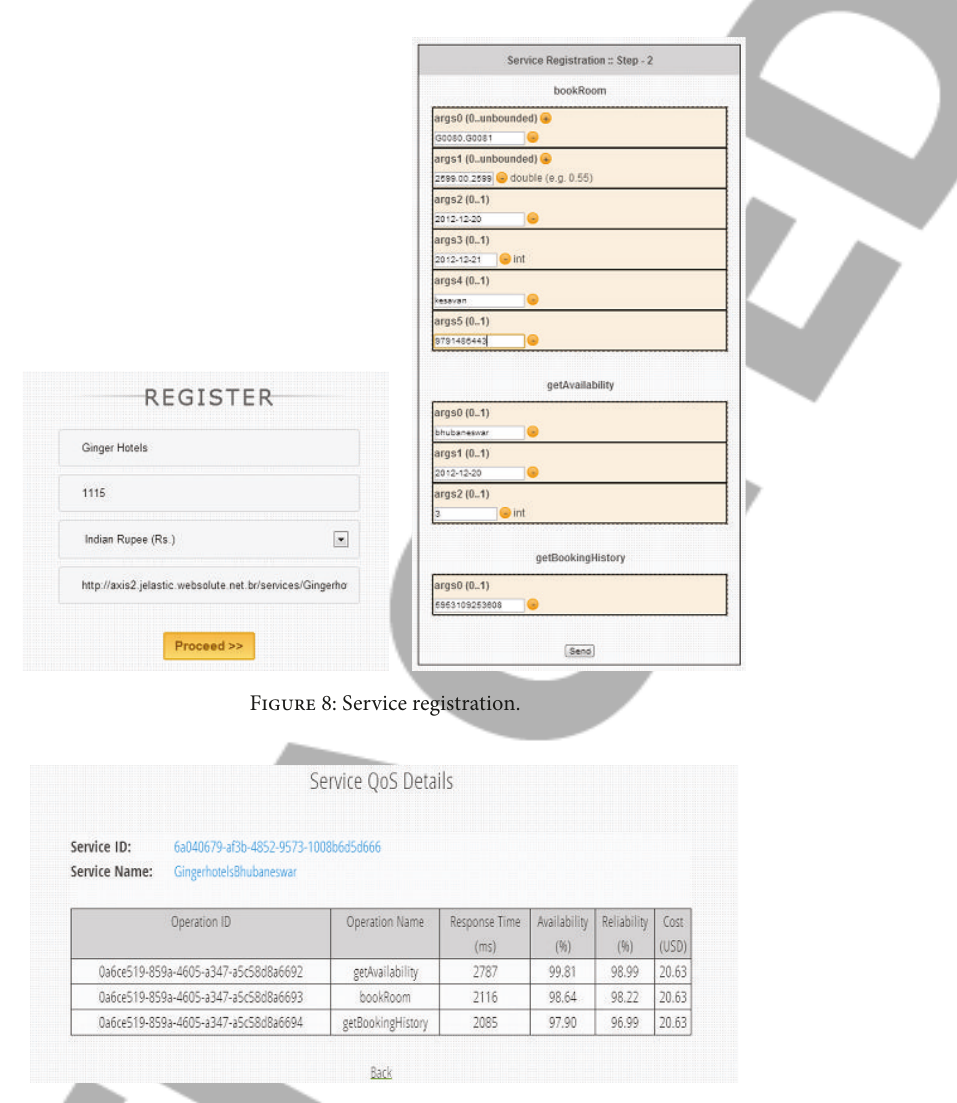
Figure 9: QoS assessment for web service: Ginger Hotels.